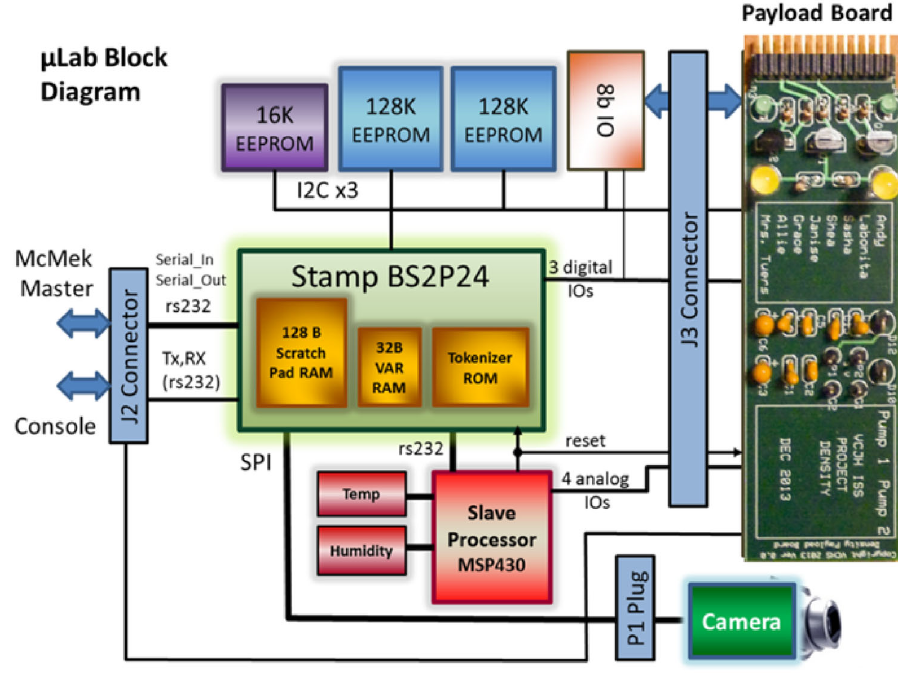
Fig. 3 µLab block